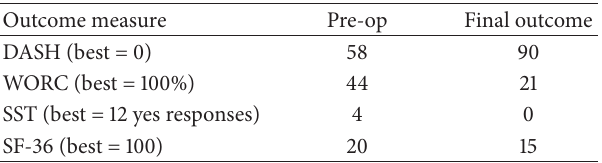
Table 3: The patient’s values for the DASH score [51, 52], WORC score [53], Simple Shoulder Test (SST) [54], and SF-36 [55] prior to the removal of the reverse shoulder prosthesis and at one year after the final spacer had been placed. For the SF-36 all questions are scored from 0 to 100 representing the highest level of functioning